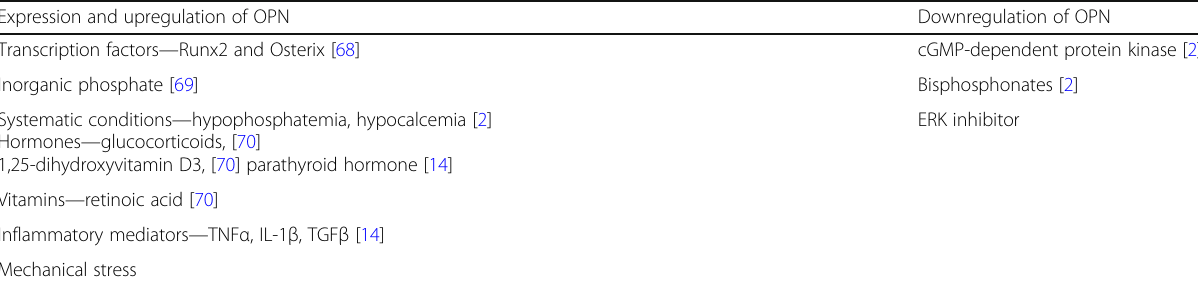
Table 1 Factors affecting the expression and regulation of osteopontin Expression and upregulation of OPN Downregulation of OPN